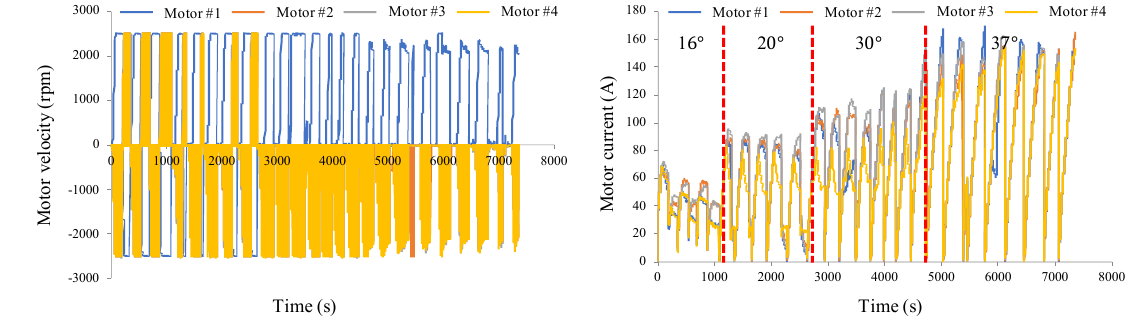
Figure 9. Testing data of